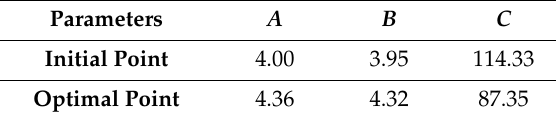
Table 7. Initial and optimal stem dimensions.